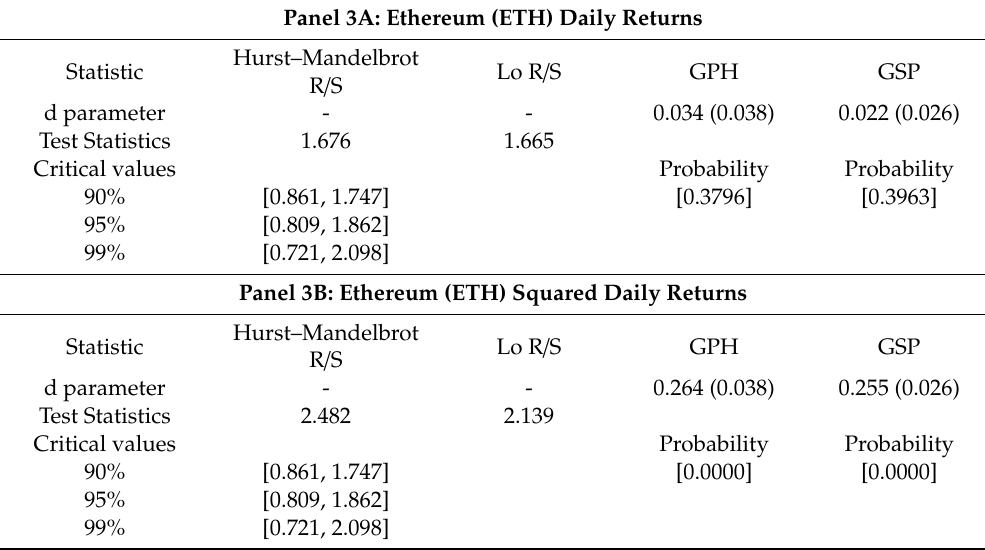
Table 3. Long Memory Tests for Ethereum Return and Squared Return.